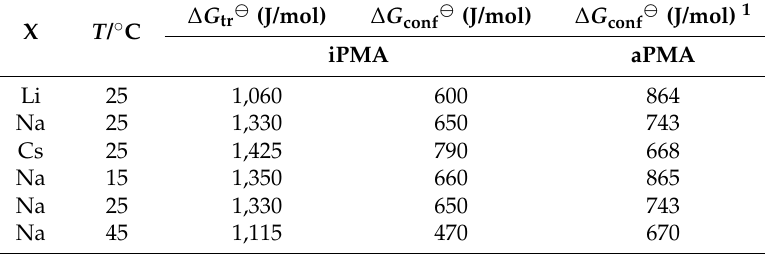
Table 1. Values of the standard Gibbs free energy changes, ∆ G tr and ∆ G conf , accompanying the (cid:23) (cid:23) transition of the iPMA and aPMA chains from the compact to the extended form in aqueous 0.01 M XCl solutions (X = Li, Na, Cs) at 15, 25, and 45 ˝ C. ∆ G ∆ G tr (cid:23) (J/mol) conf (cid:23) X T / ˝ C